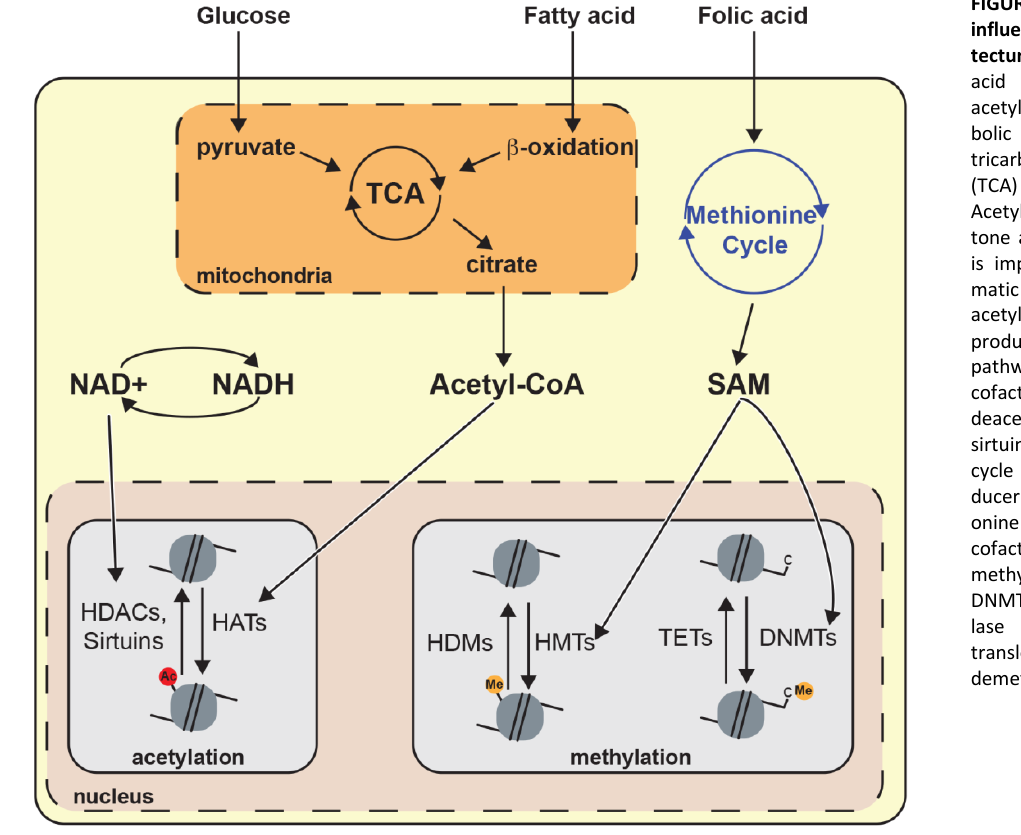
FIGURE 2: Metabolites influence chromatin archi- tecture. Glucose and fatty acid catabolism